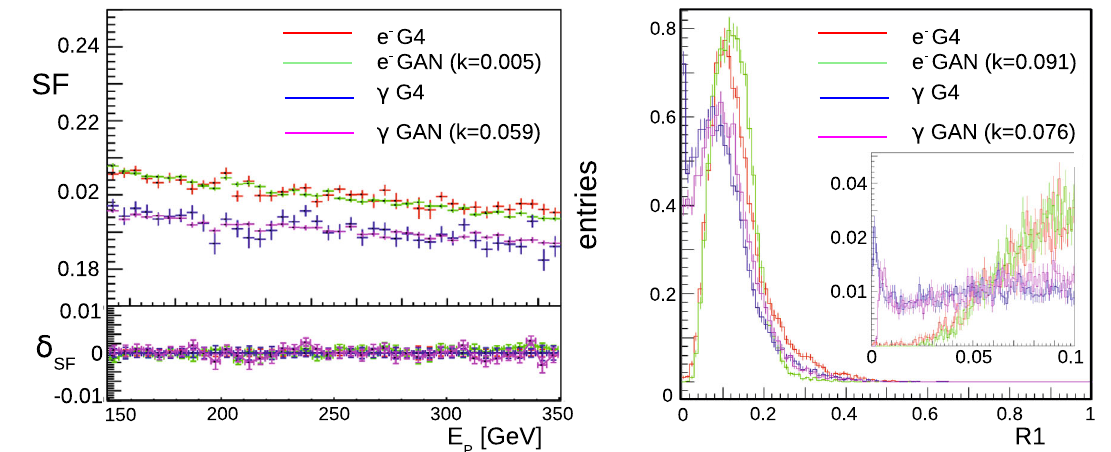
Fig. 11 The GAN could successfully learn the photon features after further training a network generating electrons with reduced E P range. (Left) the SF for photons is lower than electrons both in GEANT4 events and GAN events. The bottom panel shows the relative error ( δ SF ) for the sampling fraction. The k denotes the p-value from the Kol-